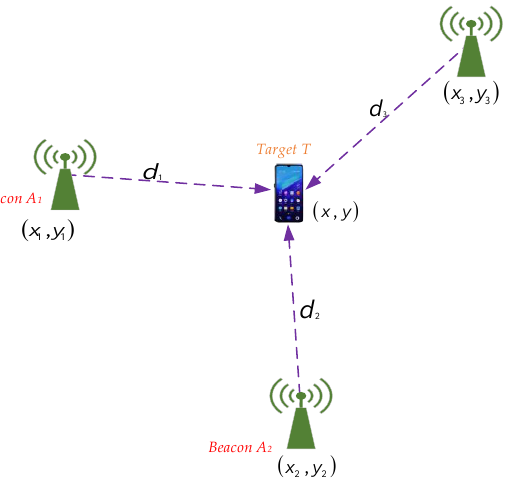
Figure 4. Spatial geometric location map with three beacons (𝐴 1 , 𝐴 2 , 𝐴 3 ) and the target T